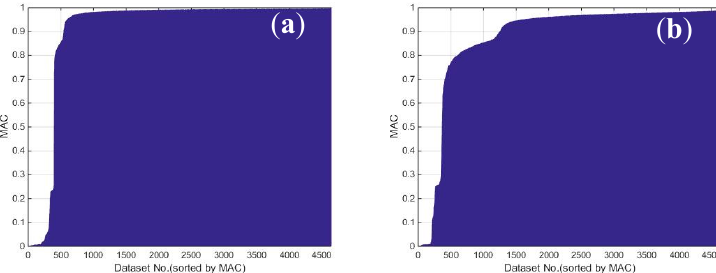
Figure 9. The sorted MAC values of the two typical candidate modes: ( a ) modal frequency 2.03 Hz; and ( b ) modal frequency 8.26 Hz.